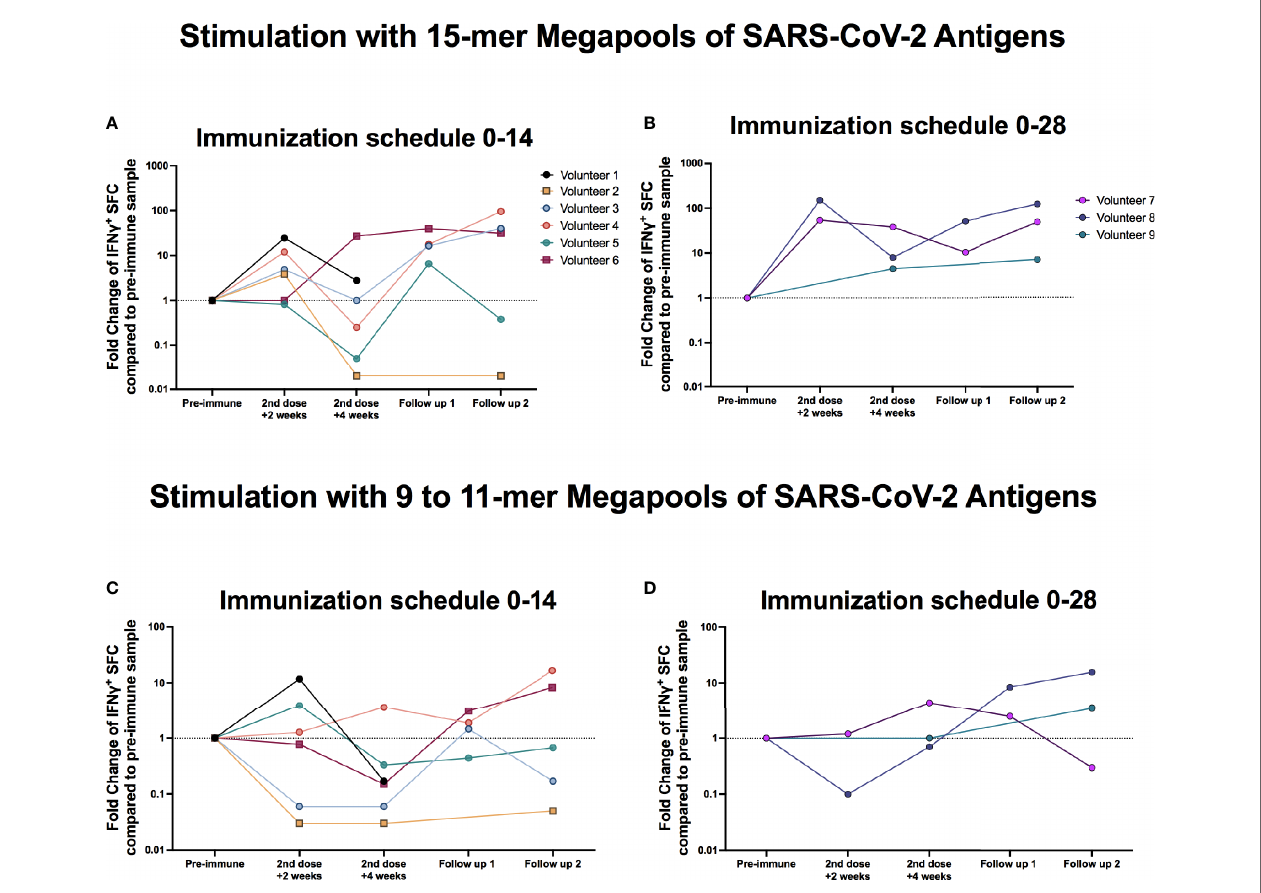
FIGURE 4 | The IFN- g production by T cells from breakthrough cases after stimulation with MegaPools of SARS-CoV-2 peptides is heterogeneous. PBMCs from the nine breakthrough cases were obtained before administration of the fi rst dose (pre-immune), 2 and 4 weeks after the second dose, and 2 and 4 weeks after the disease onset (follow-up 1 and 2, respectively) and evaluated by ELISPOT assays. Cells were stimulated for 48 h with two MPs containing several peptides from SARS-CoV-2 to induce the secretion IFN- g by T cells. The number of spots-forming cells (SFCs) was evaluated. Data are shown as the fold increase regarding to the preimmune value for SFCs. (A) Fold change of IFN- g + SFCs after stimulation with MPs containing 15-mer peptides from SARS-CoV-2 of six volunteers enrolled at the 0 – 14 immunization schedule. (B) Fold change of IFN- g + SFCs after stimulation with MPs containing 15-mer peptides from SARS-CoV-2 of three volunteers enrolled at the 0 – 28 immunization schedule. (C) Fold change of IFN- g + SFCs after stimulation with MPs containing 9- to 11-mer peptides from SARS-CoV-2 of six volunteers enrolled at the 0 – 14 immunization schedule. (D) Fold change of IFN- g + SFCs after stimulation with MPs containing 9- to 11-mer peptides from SARS-CoV-2 of three volunteers enrolled at the 0 – 28 immunization